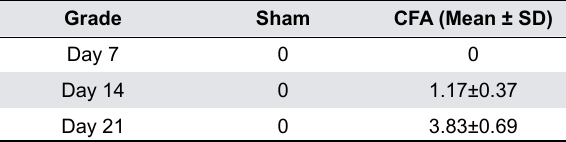
Table 1- Graded scores of the temporomandibular joint osteoarthritis in the sham and complete Freund’s adjuvant (CFA)